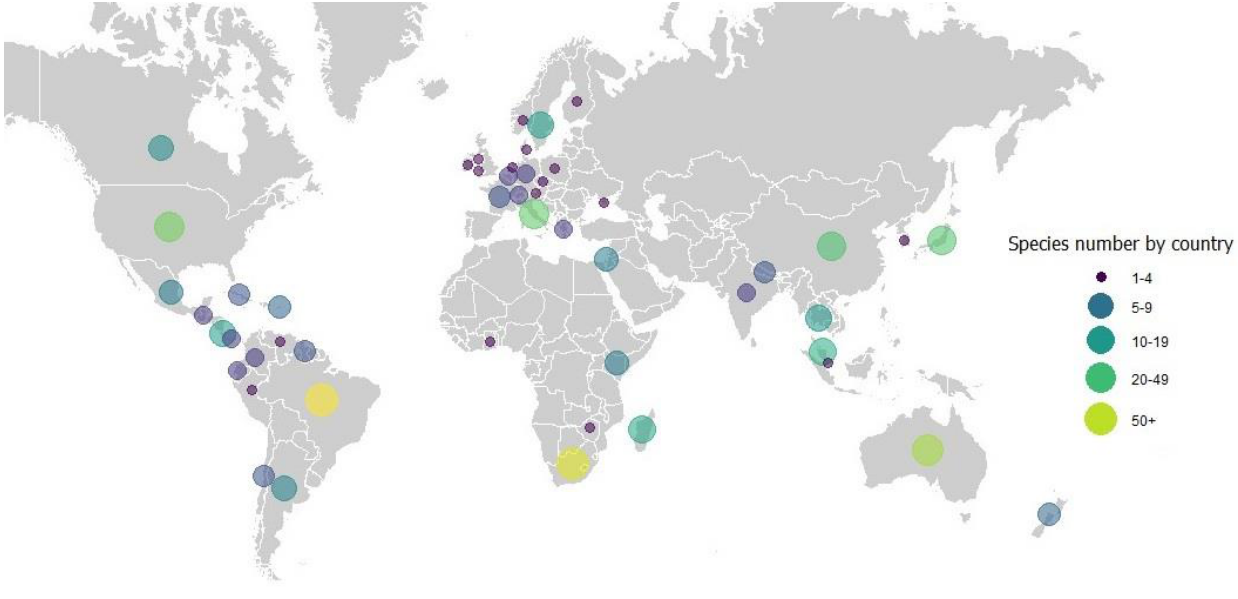
Figure 6. Global distribution map of the orchid pollination studies included in this review. The larger the circle, the more orchid species that were studied in that